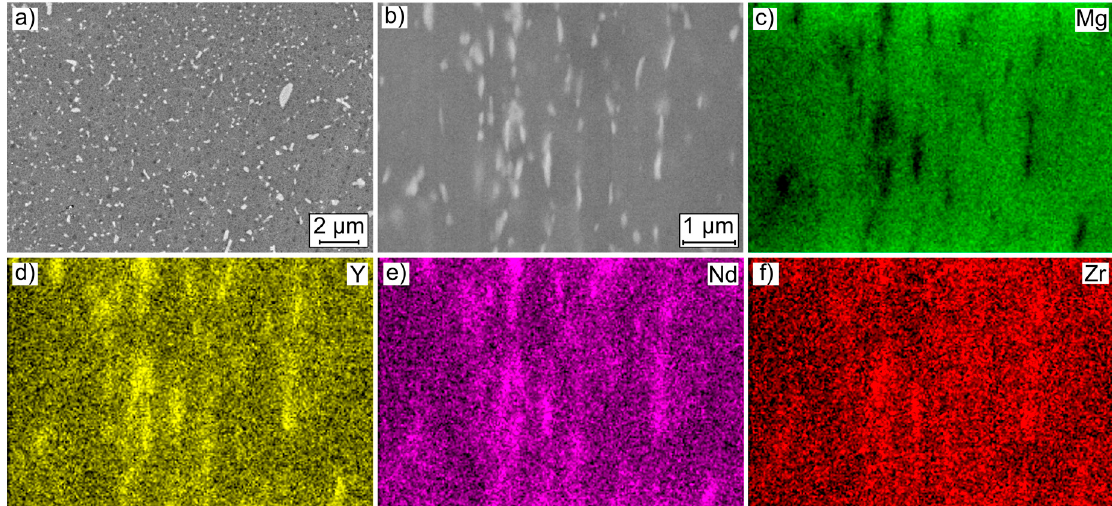
Figure 2. Results of microstructural investigations on Mg WE43 MEO: ( a ) SEM images of cross section; ( b ) SEM images of longitudinal section for EDS mapping of ( c ) Mg, ( d ) Y, ( e ) Nd and ( f )